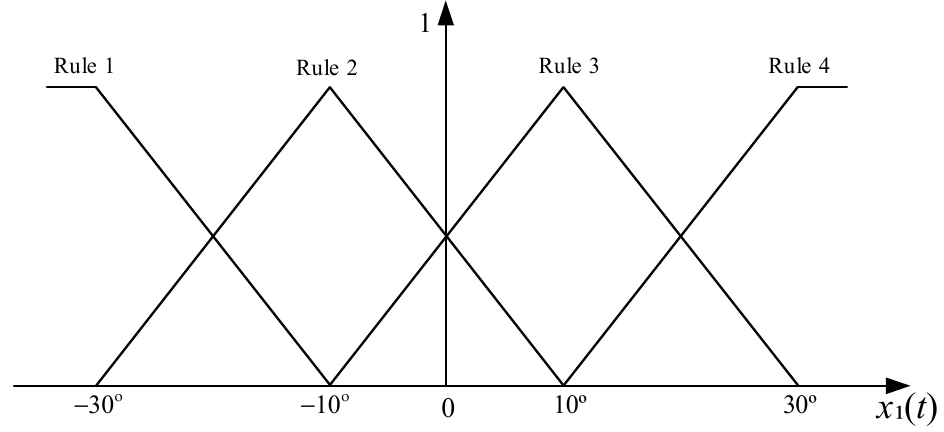
Commented [M34]: Please change hyphens in the figure which mean minus into minus signs.